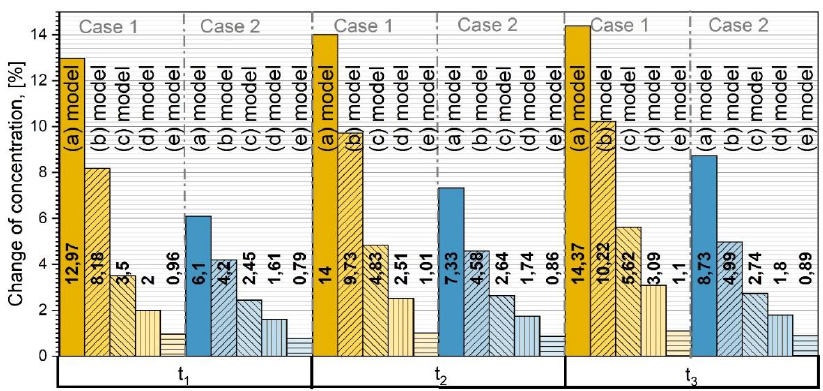
Figure 7. The quantitative comparison of diffusion in grains of polycrystalline material of different models (see Figure 2) with corresponding monocrystalline material of the same volume at three different moments of time and for Cases 1 and 2.